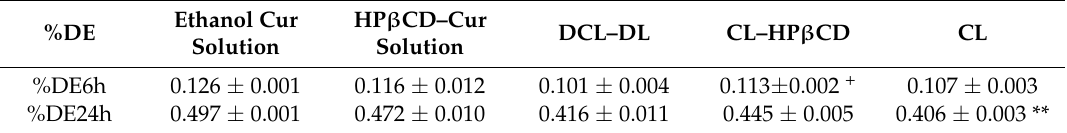
Table 7. Dissolution efficiency percentage at 6 h (%DE6h) and at 24 h (%DE24h) of release profiles. Data shown as means ± SD. The mean value was significantly different compared with CL–HP β CD liposomes (** p < 0.01; Student t test). The mean value was significantly different compared with DCL–DL liposomes (+ p < 0.05; Student t -test).